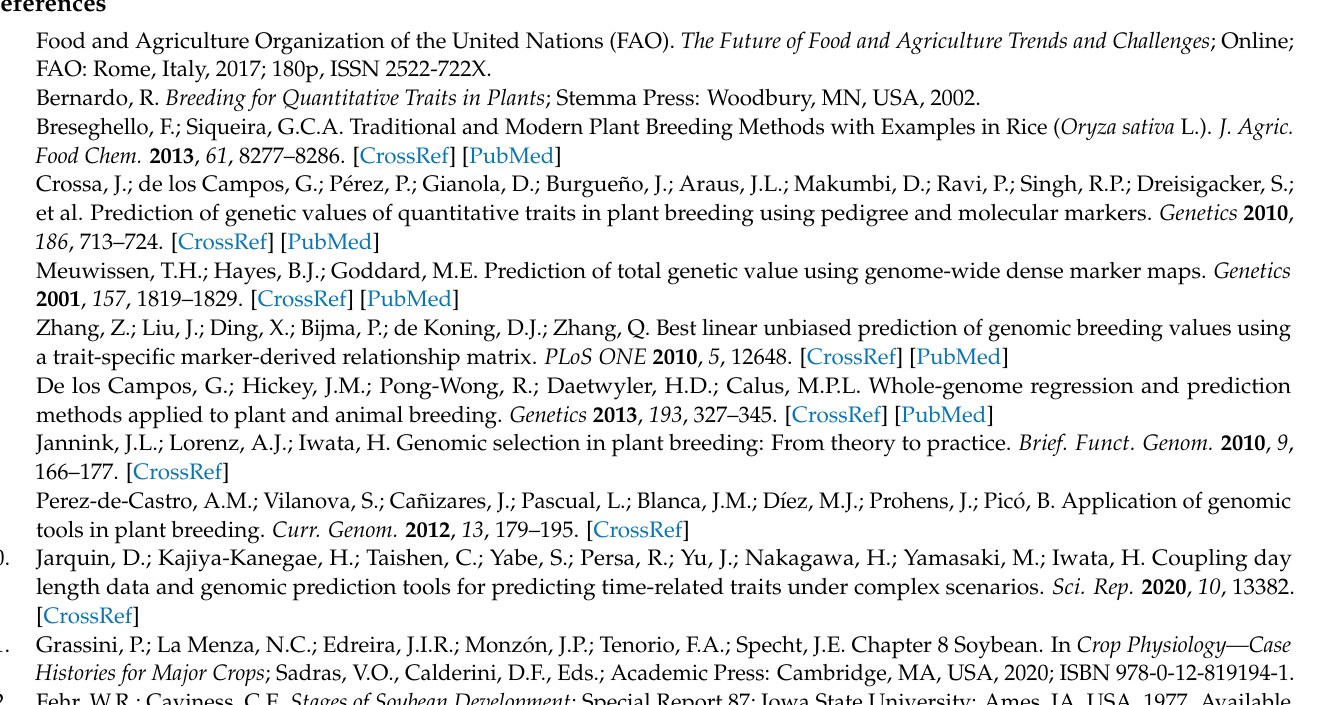
Table S1: Phenotypic information of days to maturity in 11; Matrix of molecular markers: